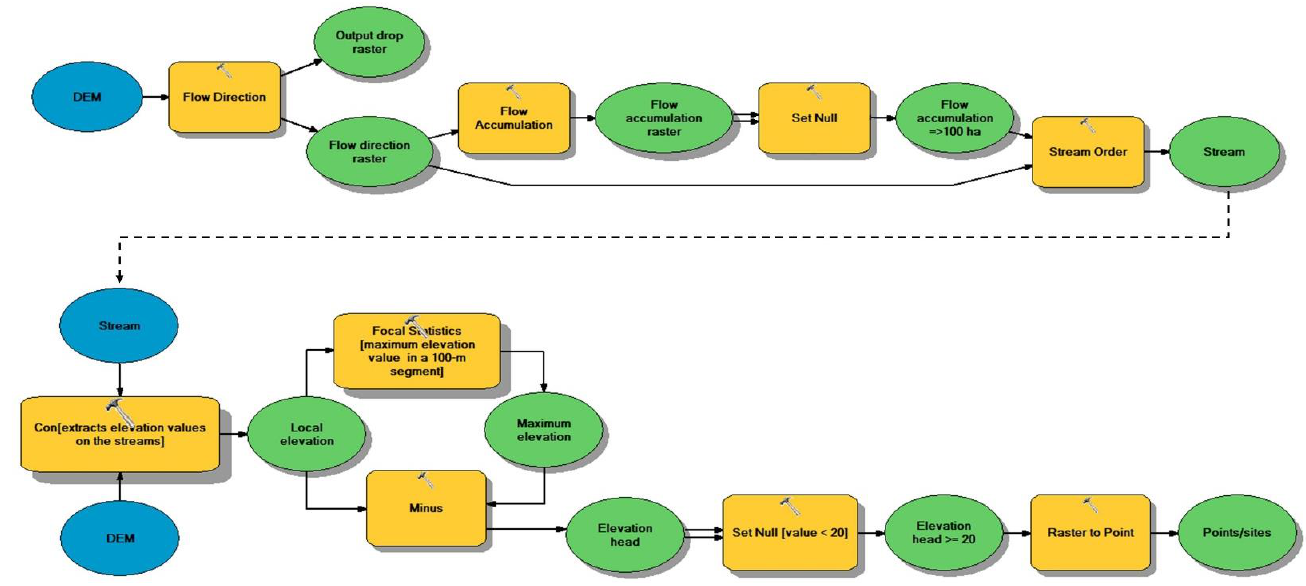
Figure 2. A model builder created for locating points with a minimum elevation head of 20 m along river channels. The yellow-colored rectangle with the hammer sign indicates the toolset used in the analysis. The blue-colored oval shape indicates the input data while the green-colored indicates the output.